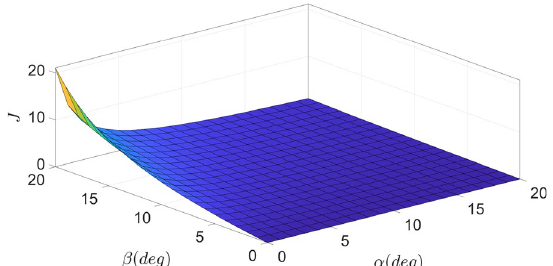
Fig. 13 NPL “ b N ” parameter